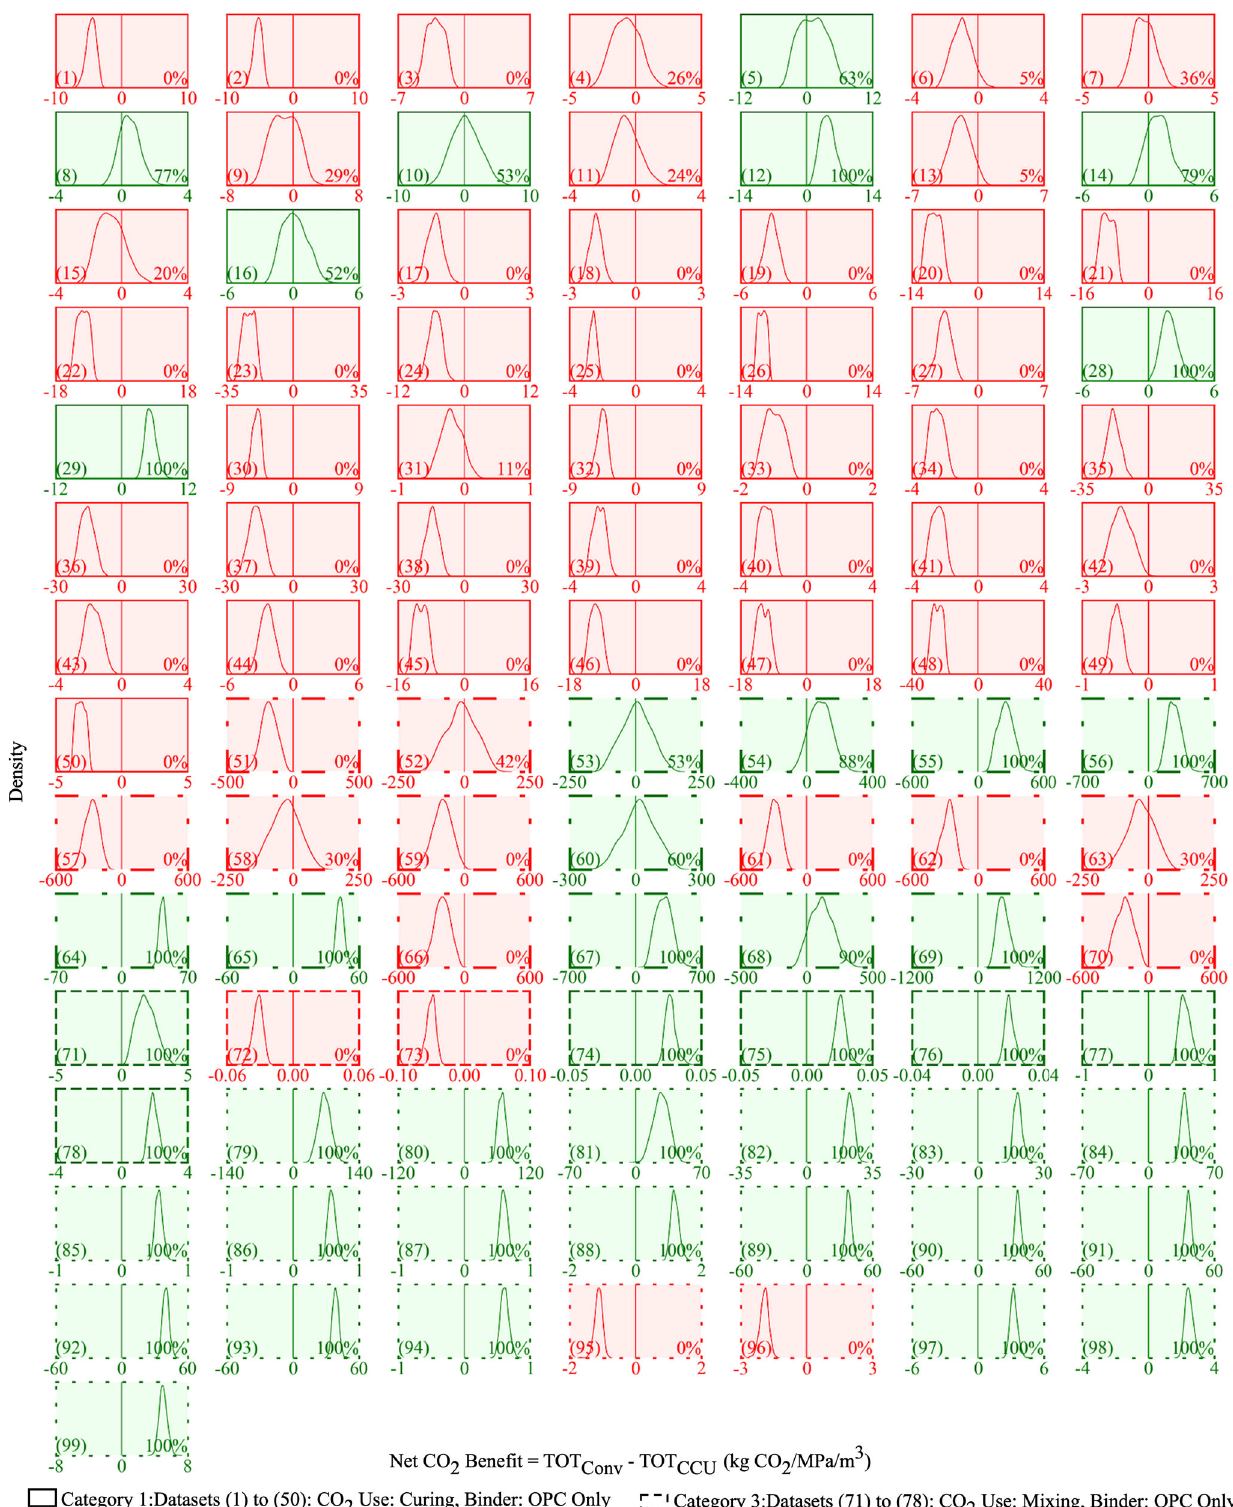
Fig. 3 The net CO 2 bene fi t of CCU concrete production across 99 datasets. The curve in each plot represents the distribution of the net CO 2 bene fi t, which is the difference between the total CO 2 emissions from producing conventional and CCU, across 10,000 Monte Carlo runs. When the net CO 2 bene fi t is negative in at least 5000 of the 10,000 Monte Carlo runs (50% likelihood), the background is red. If the background is green, then it signi fi es that the net CO 2 bene fi t is positive with a likelihood greater than 50%. The likelihood is presented as a percentage value in the lower right corner of the plot. The parenthesized value in the lower left corner is the dataset